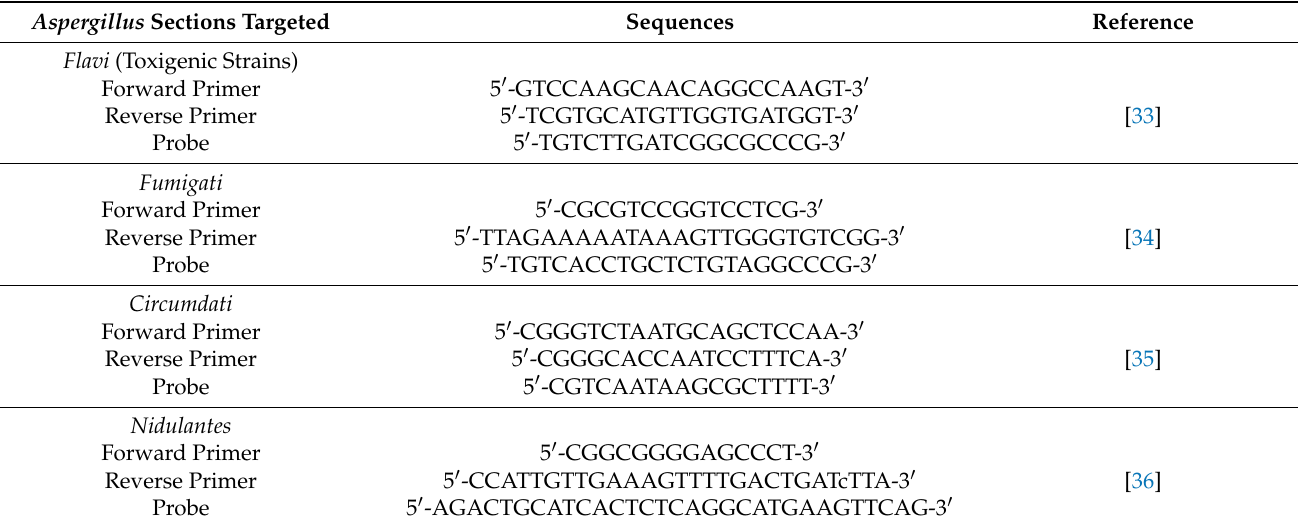
Table 1. Sequence of primers and TaqMan probes used for real time